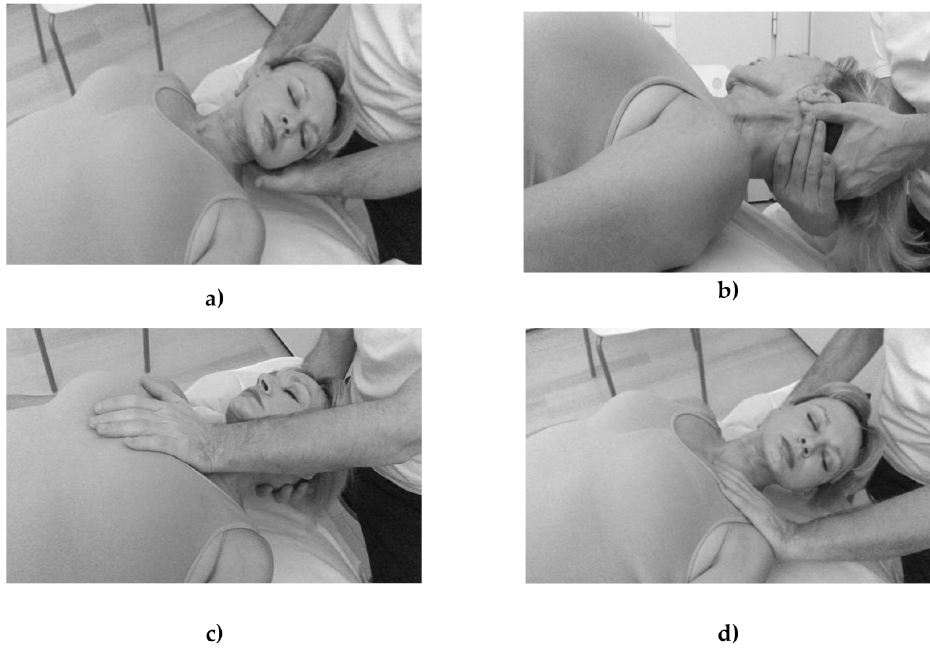
Figure 2. ( a – d ) Myofascial unwinding description over the neck